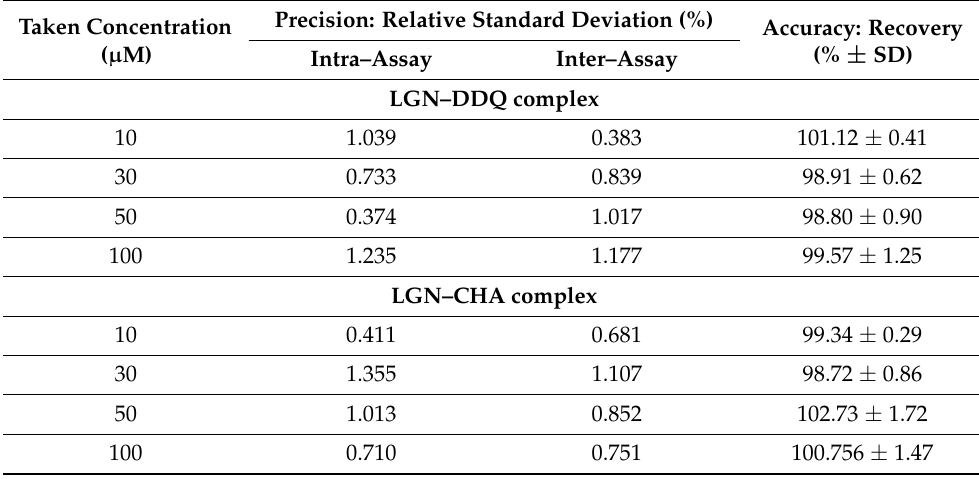
(% ± SD)Intra–Assay Inter–Assay